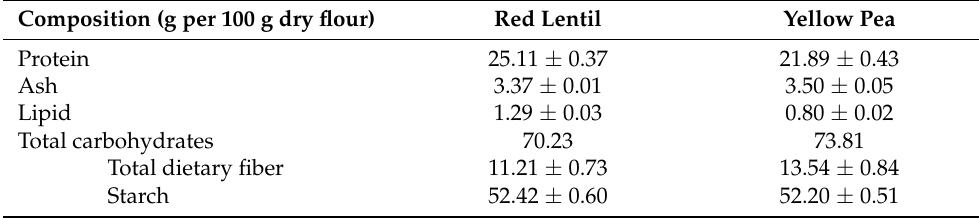
Table 2. Proximate composition (mean ± standard error) of red lentil and yellow pea flours. Composition (g per 100 g dry